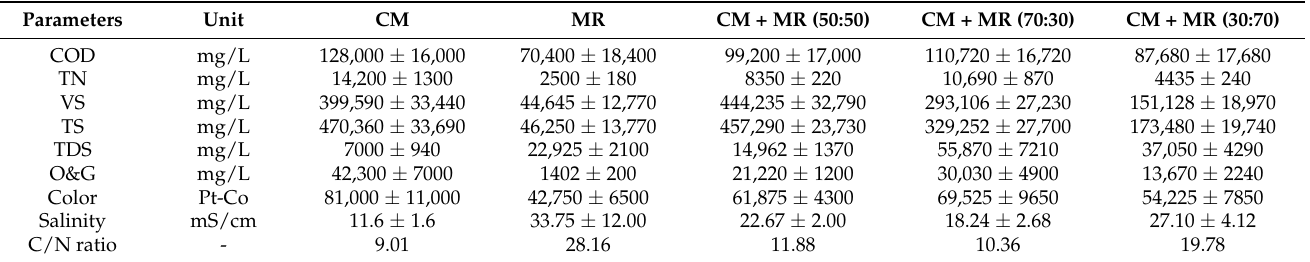
Table 1. Physicochemical characteristics of raw cow manure (CM), molasses residue (MR), and co-digestion of cow manure and molasses residue (CM + MR).